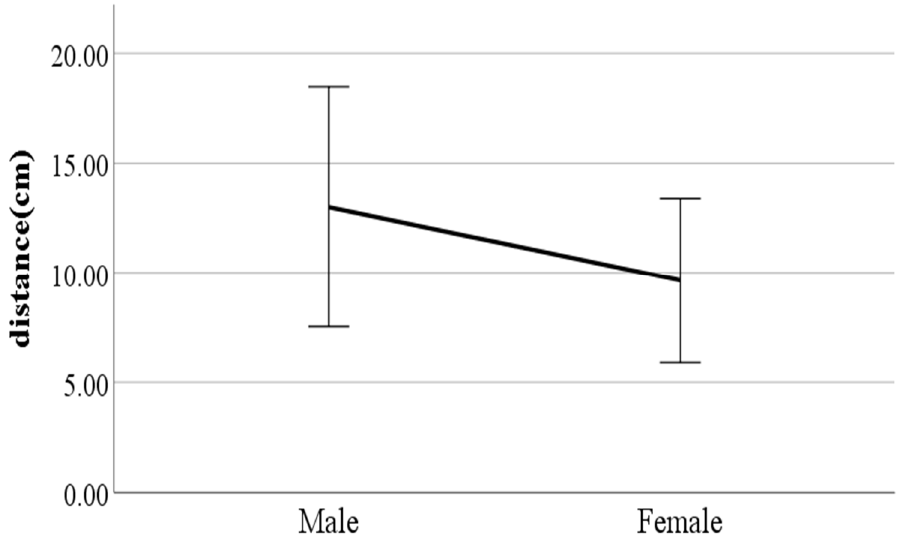
Figure 6. Gender difference in distance between the feet (F value: 13.40, DF: 289, p -value: 0.00).